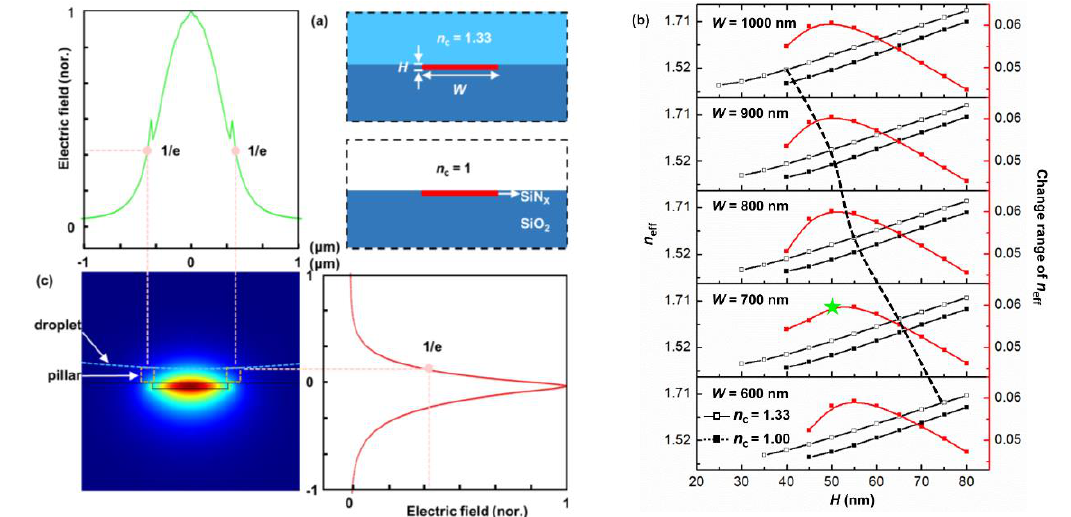
Figure 3. ( a ) A built-in and planar waveguide without pillars above; ( b ) Effective refractive index with respect to waveguide geometry. The dashed line is the boundary of the single mode operation; ( c ) The mode field distribution of the strip waveguide with W = 700 nm and H = 50 nm.